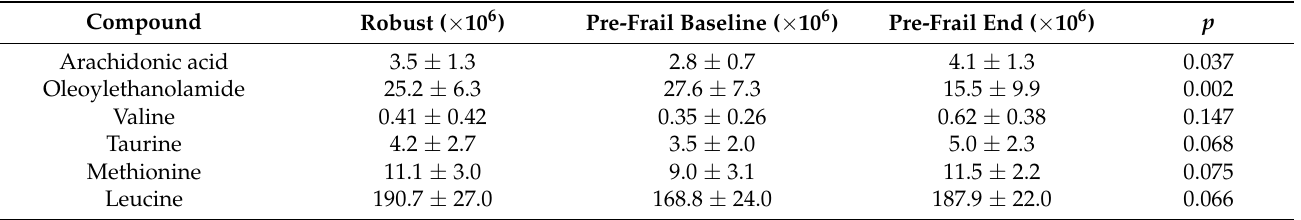
Table 3. Observed peak area of selected compounds among robust and pre-frail patients (at baseline, and at the end of